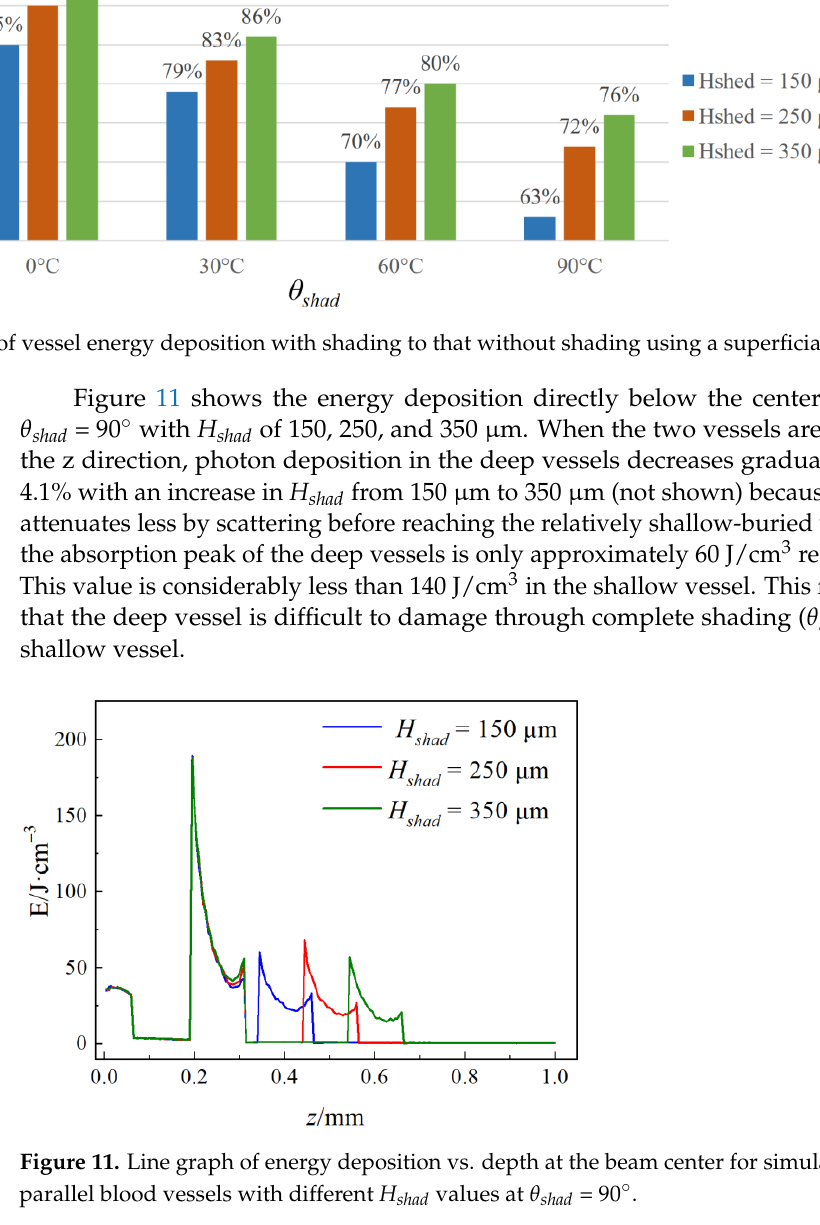
( b ) Without shading Figure 9. Cross-sectional view of the skin model with parallel PWS vessels. Figure 10 shows the ratio of deep vessel deposition with shading to that without shading at different shading angles and distances. The shading effect is apparent with a